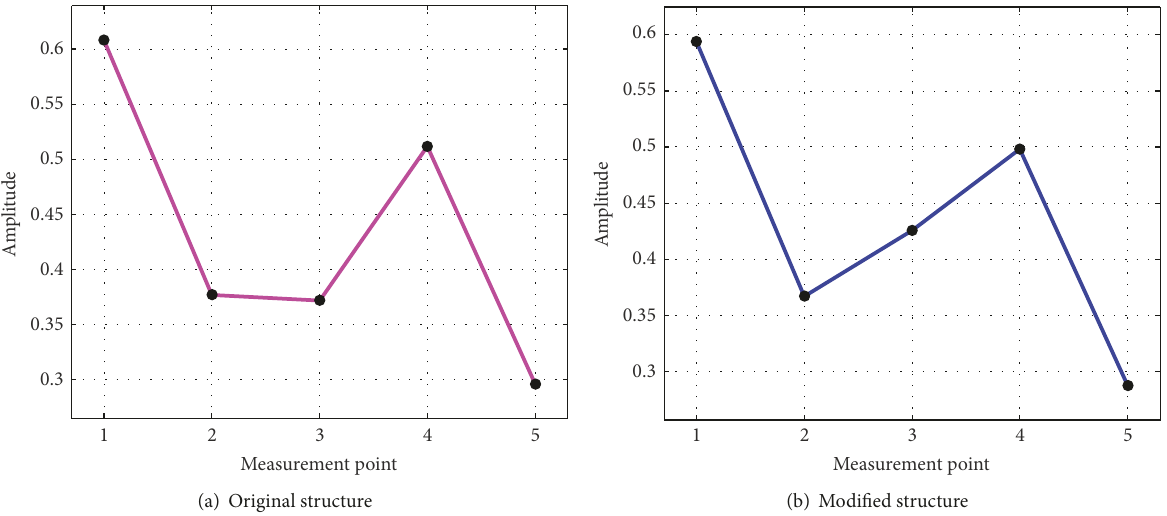
Figure 5: Mass distribution vector calculated by four modes.